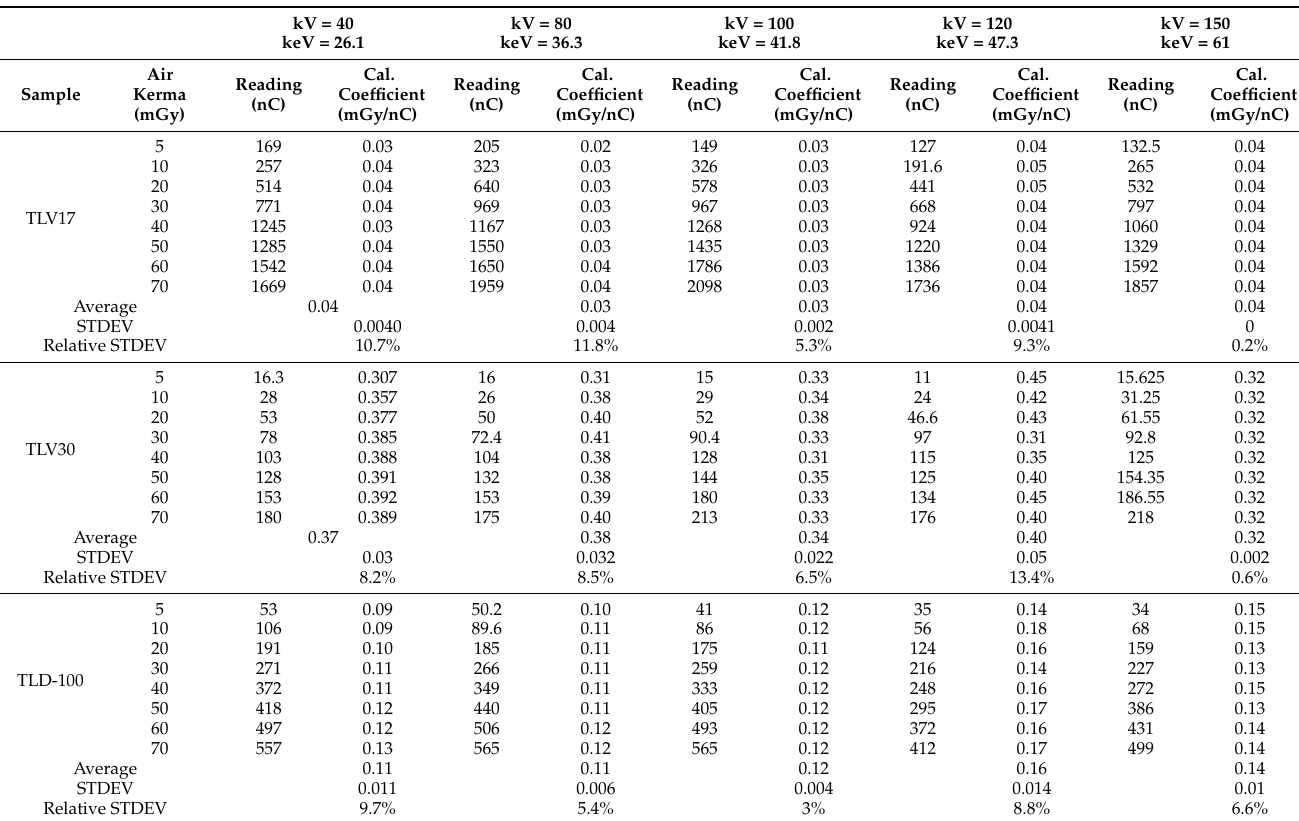
Table 3. TL dose results from X-ray irradiation from SSDL.